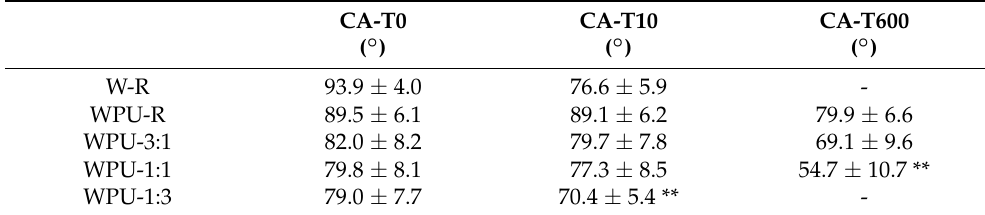
Table 4. Contact angle (CA) measured for different prepared PU formulations. Values of CA after waterdrop deposition (CA-T0), CA after 10 s (CA-T10) and CA after 10 min (600 s) after waterdrop deposition (CA-T600) are reported. Statistical differences are reported as: *** p < 0.001, ** p < 0.01 and * p <